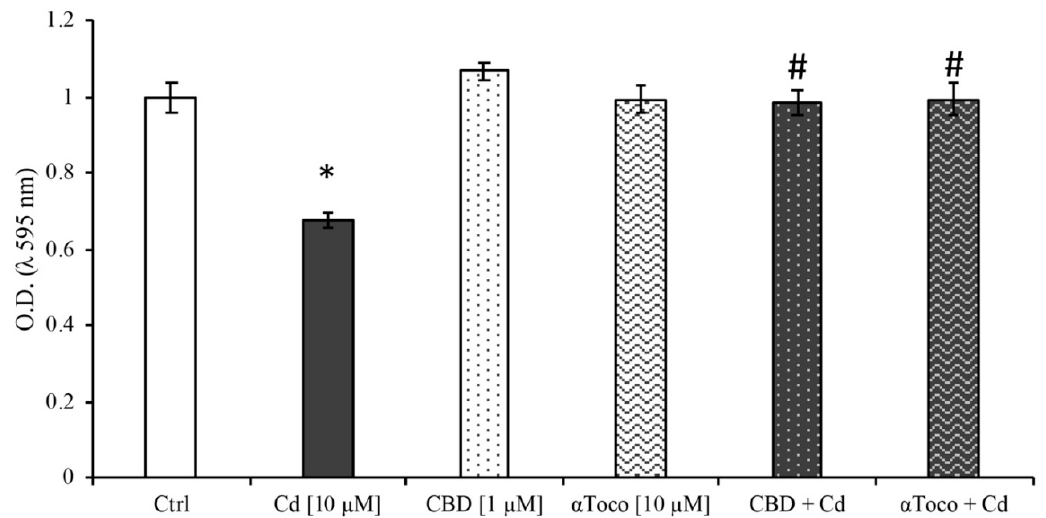
Figure 1. Cell viability on retinoic acid (RA) differentiated SH-SY5Y . An 3-(4,5-di-methyl- thiozol-2-yl)-